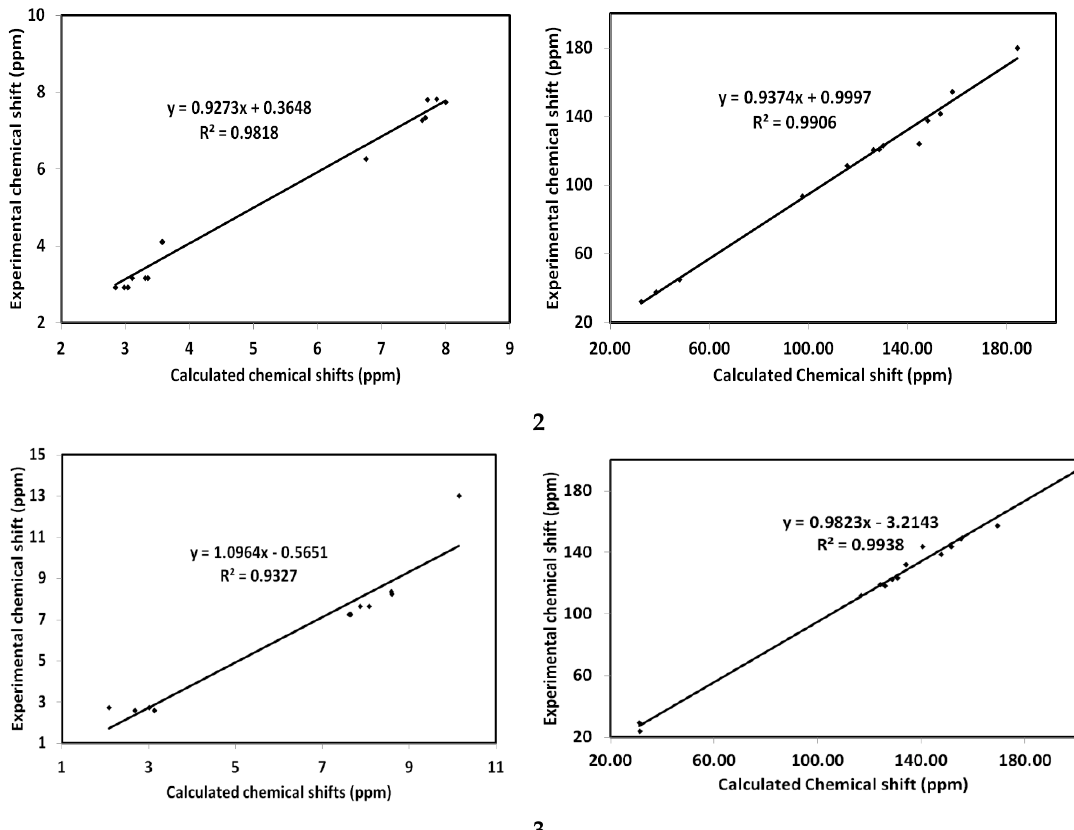
Figure 10. 1 H and 13 C NMR chemical shifts correlations.